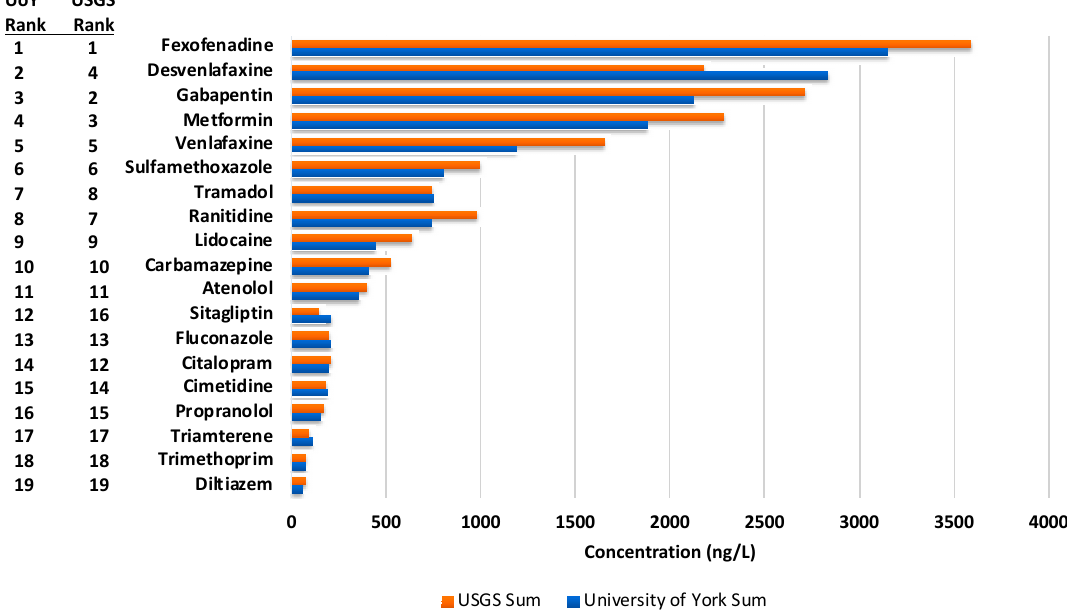
Figure 4. Sum concentrations of the 19 quantified active pharmaceutical ingredients (APIs) determined by analysis at the CoEMS and USGS respectively with their prioritisation rank determined by total concentration.